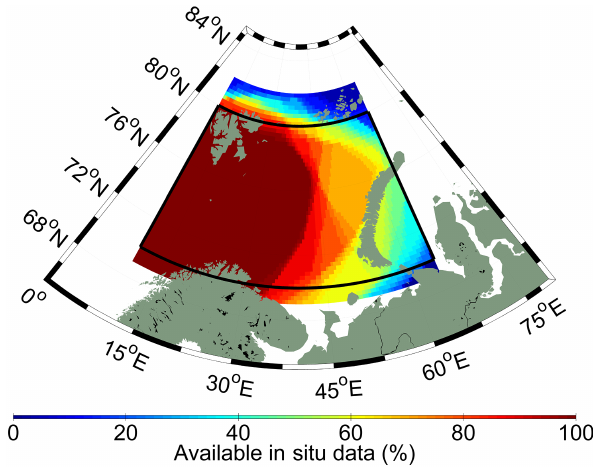
Figure 2. Available in situ data: percentage of data for the 1980– 2011